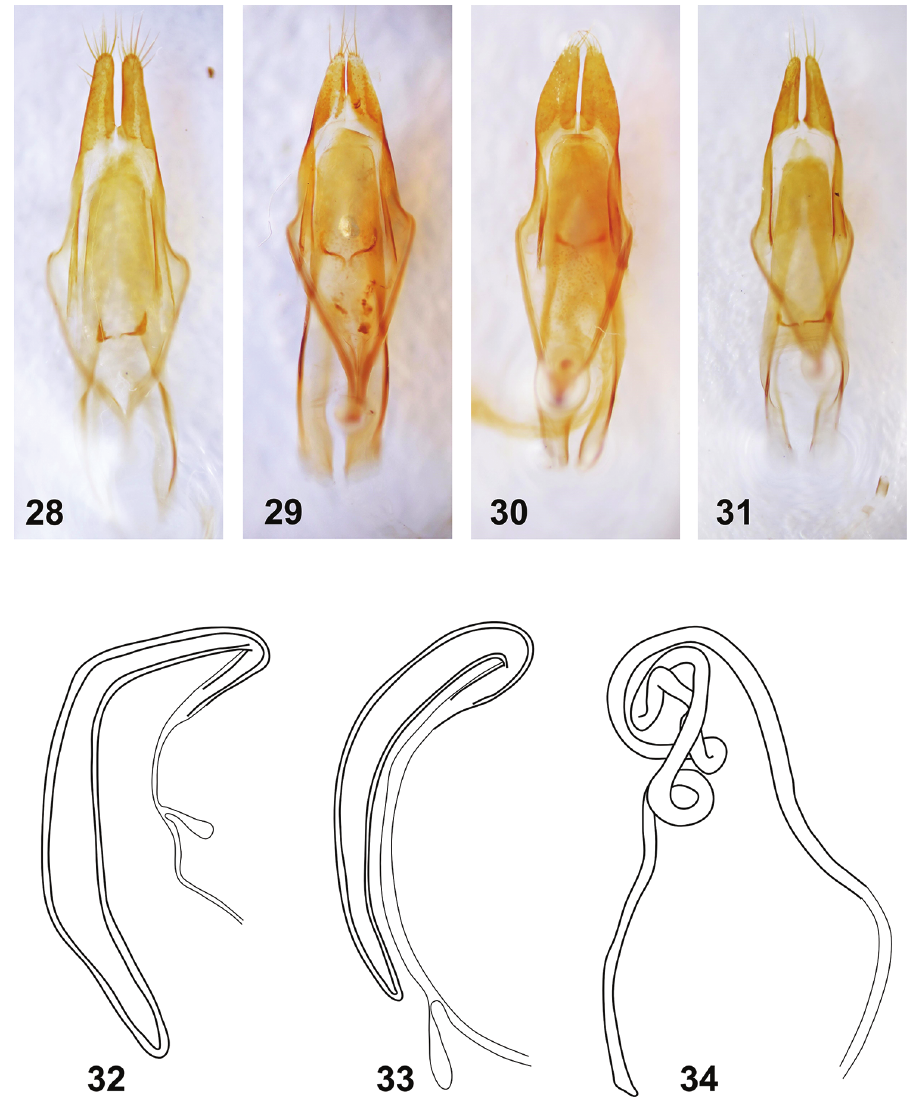
Figures 28–34. Anexodus species: 28–31 Aedeagus, ventral view: 28 Anexodus aquilus Pascoe, holotype 29 Anexodus sarawakensis Sudre, holotype 30 Anexodus syptakovae sp. n., holotype 31 Anexodus tufi sp. n., holotype 32–34 Spermatheca: 32 Anexodus aquilus Pascoe 33 Anexodus tufi sp. n. 34 Anexodus sarawak- ensis Sudre. Not to